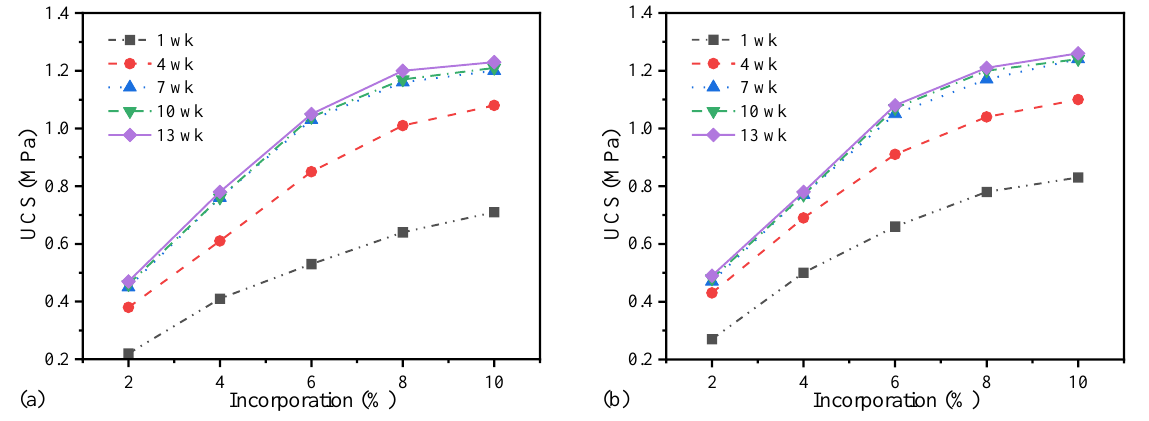
Figure 4. UCS of ( a ) ISW-improved silt and ( b ) cement-improved silt. Improved silt used as the backfill soil for subgrade depends on the compressive strength to evaluate subgrade quality. CBR is another important indicator for the charac-